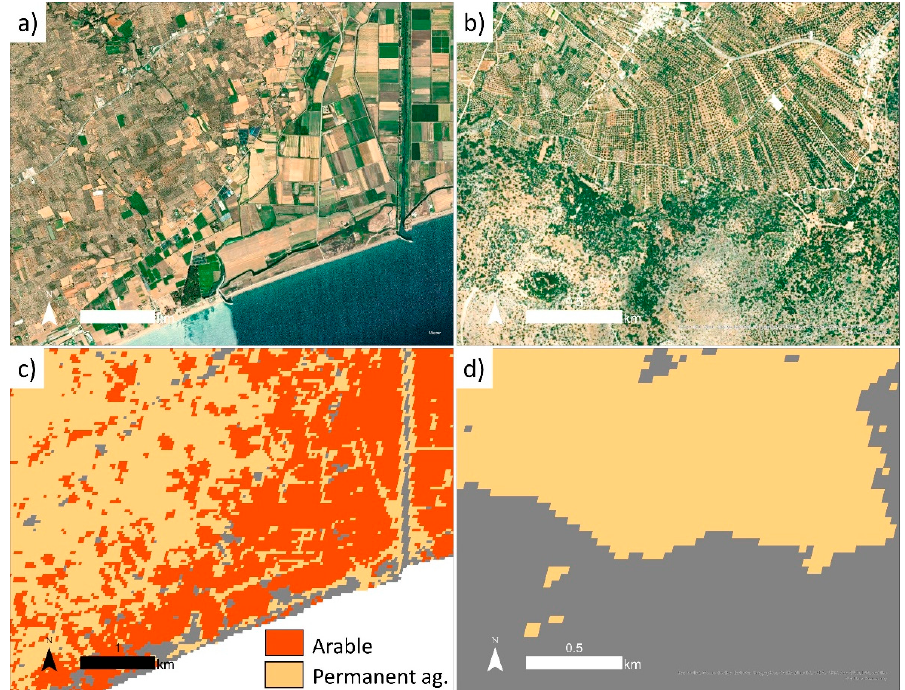
Figure 6. Arable and permanent agriculture classification examples in the year 2020 for two sites in the study area. Panels ( a , c ) show true color Maxar imagery and the agriculture classification for an area in the southern Messinia prefecture of the Peloponnese where arable and permanent agriculture are intermixed (centered on 21.997°E, 37.029°N). Panels ( b , d ) show true color Maxar imagery and the agriculture classification for an area in the Lasithi prefecture of Crete where permanent agriculture is intermixed in evergreen shrubland (centered on 25.663°E, 35.183°N). Figure 7 shows arable and permanent agriculture extent and change from 1986 to 2020. The map shows proportion of stable and change strata within 10 × 10 km grid cells. Generally, areas that exhibited the largest gain in arable land were in central Crete (Rethymno and Heraklion prefectures). Arable land loss during this time period was mainly concentrated in the central Arcadia prefecture in the Peloponnese. Permanent ag- riculture exhibited gains in nearly all regions except the central Peloponnese. Permanent agriculture gain was greatest in the west and south regions of the Peloponnese (Messinia and Laconia prefectures) and central Crete (Rethymno and Heraklion prefectures). Areas where arable to permanent agriculture conversion occurred were rare except for a hotspot in the Ilia region of western Greece (Figure 7, bottom left pane). Figure 8 shows example hotspots of arable and permanent agriculture expansion.